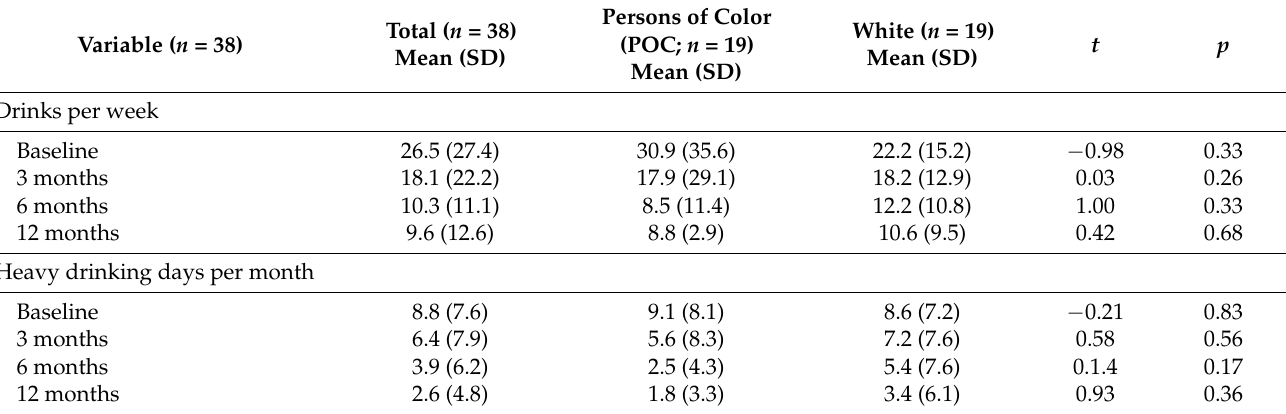
Table 4. Drinking behavior across study